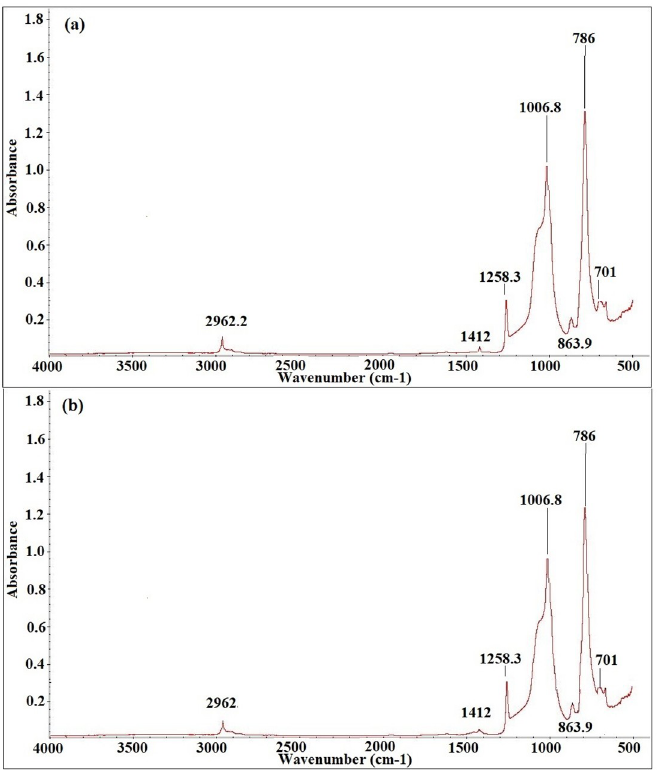
Fig 13. Spectrograph for SN4 a) Before aging, b) After